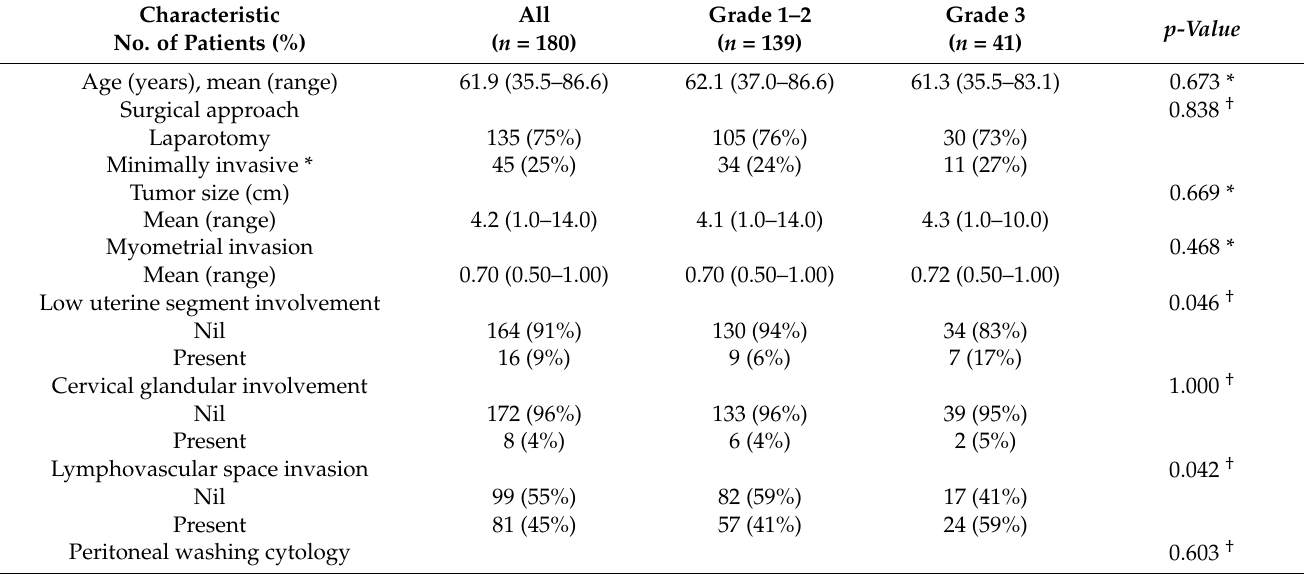
Table 1. Patients’ demographics and tumor characteristics ( n =